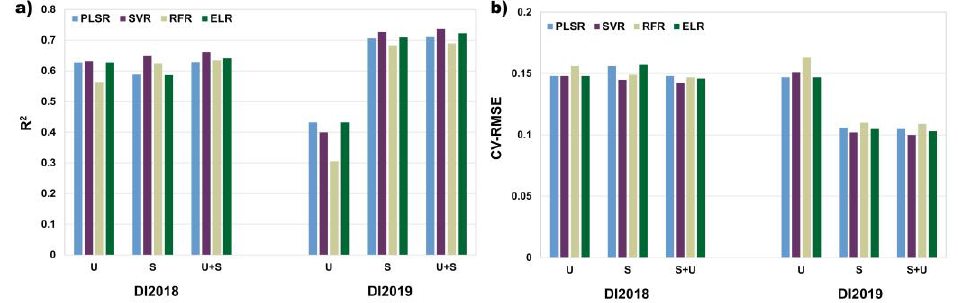
Figure 12. R 2 and coefficient of variance of the root mean square error (CV-RMSE) of DI2018 and DI2019 estimates with different machine learning methods using UAV-derived canopy infor- mation (U), satellite-based spectral information (S), and the fusion of both